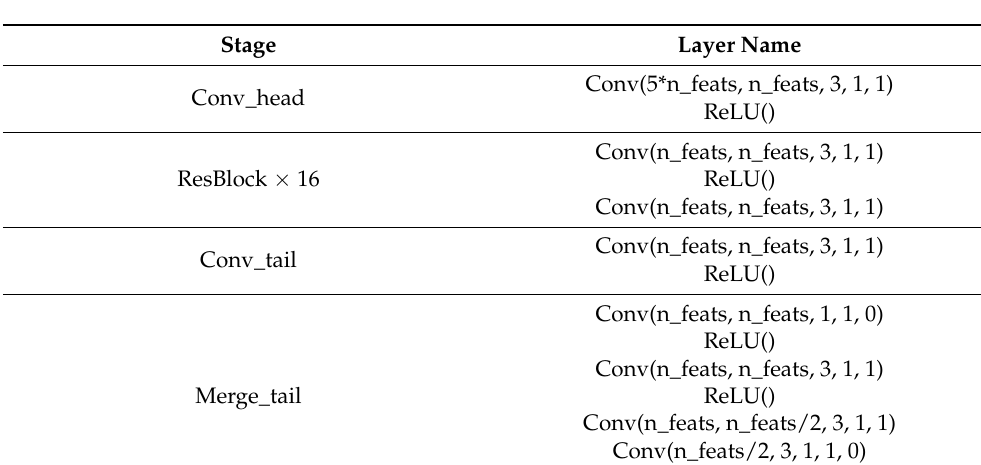
Table A3. The detailed structure of DN.